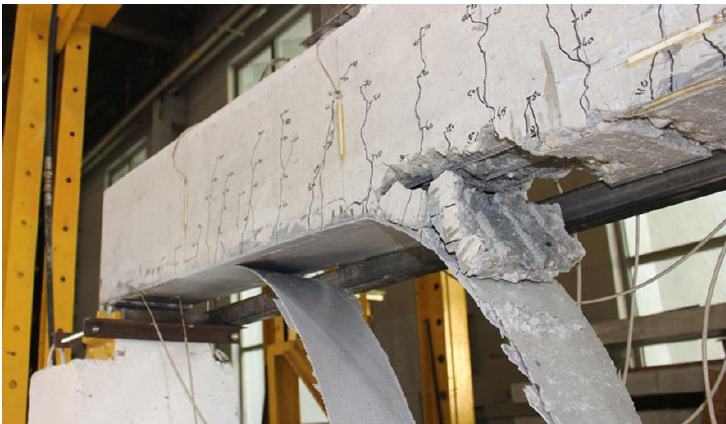
Figure 5. Debonding failure of beam strengthened with two layers of SRP textile composite.